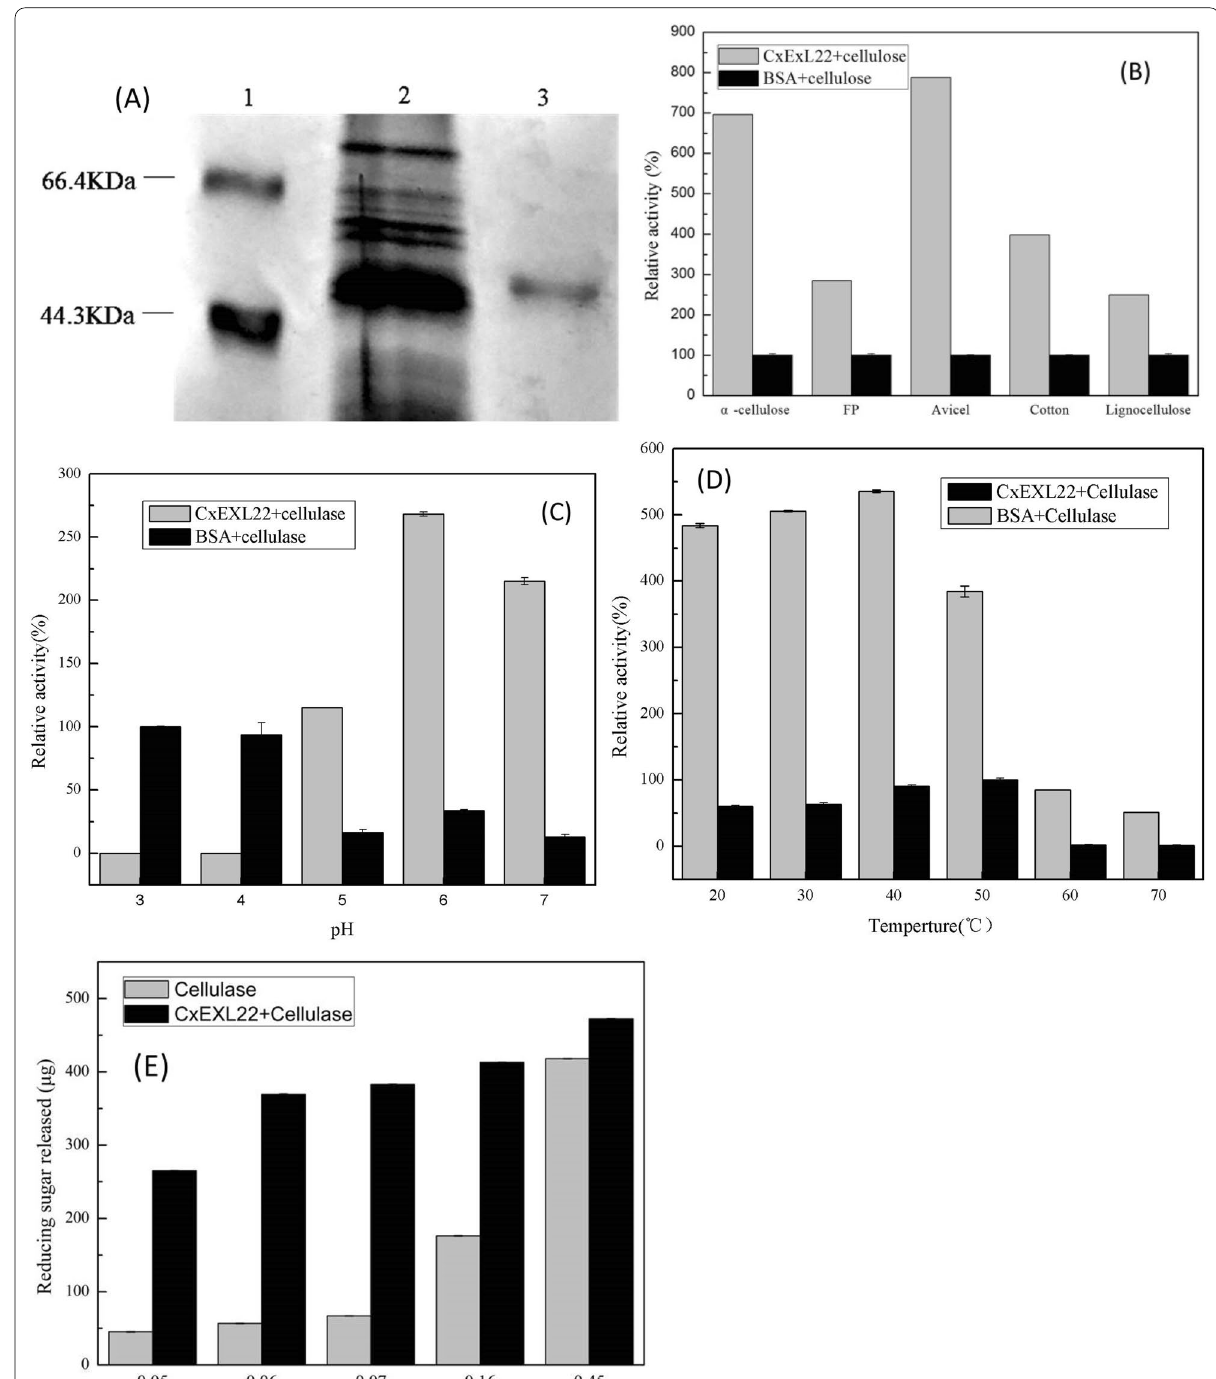
Fig. 3 Characterization of CxEXL22. A SDS-PACE for the expression of CxEXL22; B synergistic effect of CxEXL22 and commercial cellulase on cellulose hydrolysis; C effect of pH; D effect of temperature; E effect of cellulase loading on